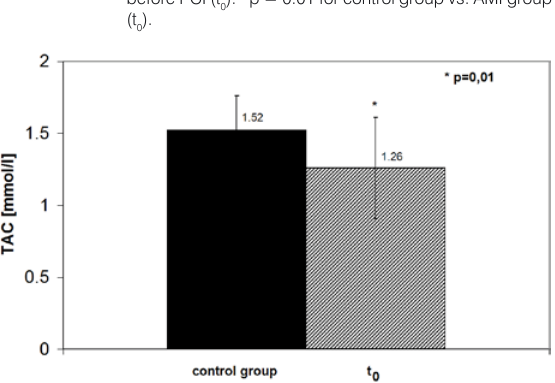
Figure 4. ETAC levels in patients with AMI before PCI (group t0)